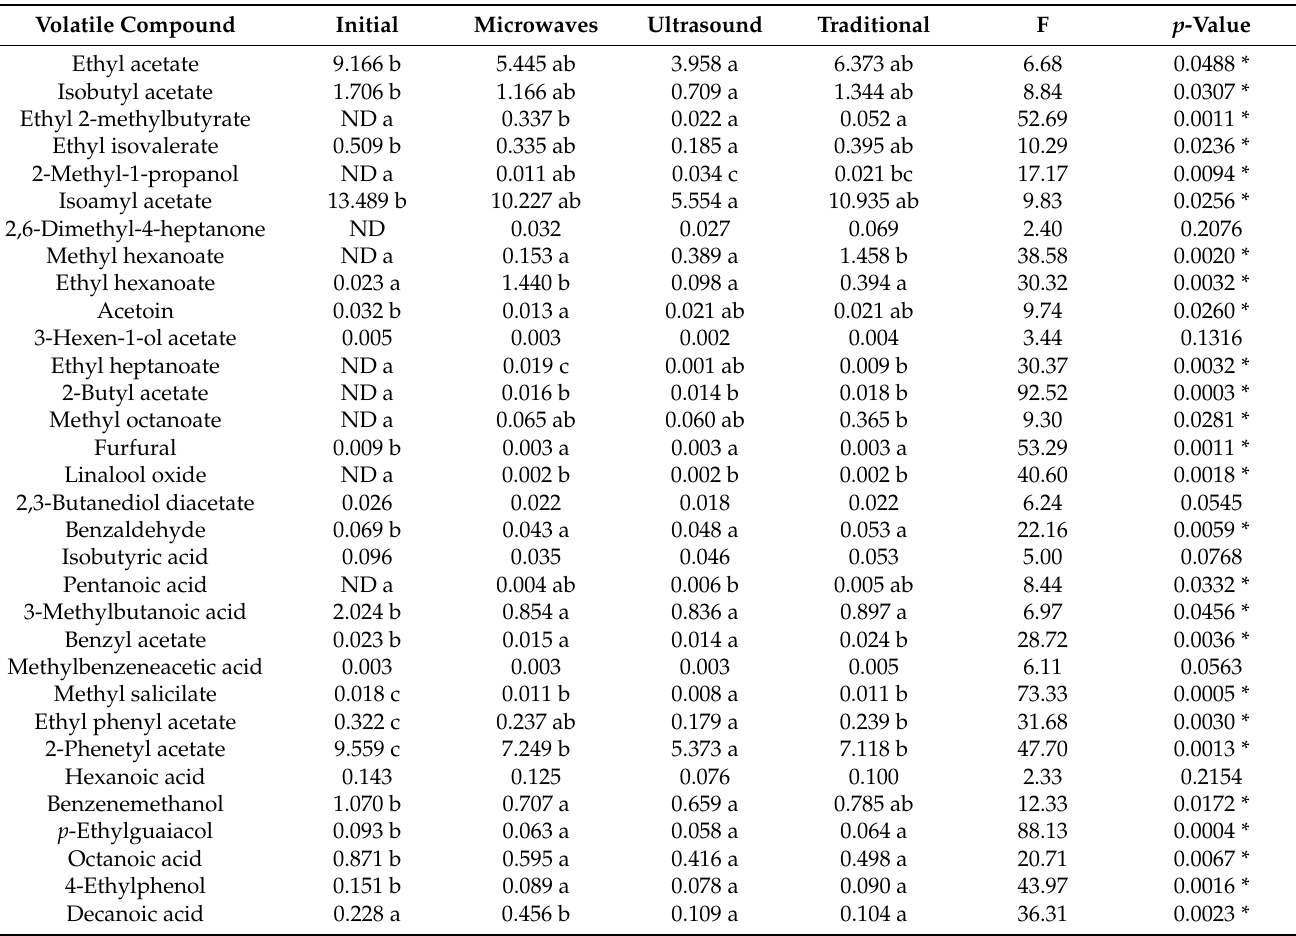
Table 5. Mean values of the relative areas ( n = 4) of the volatile compounds studied and ANOVA